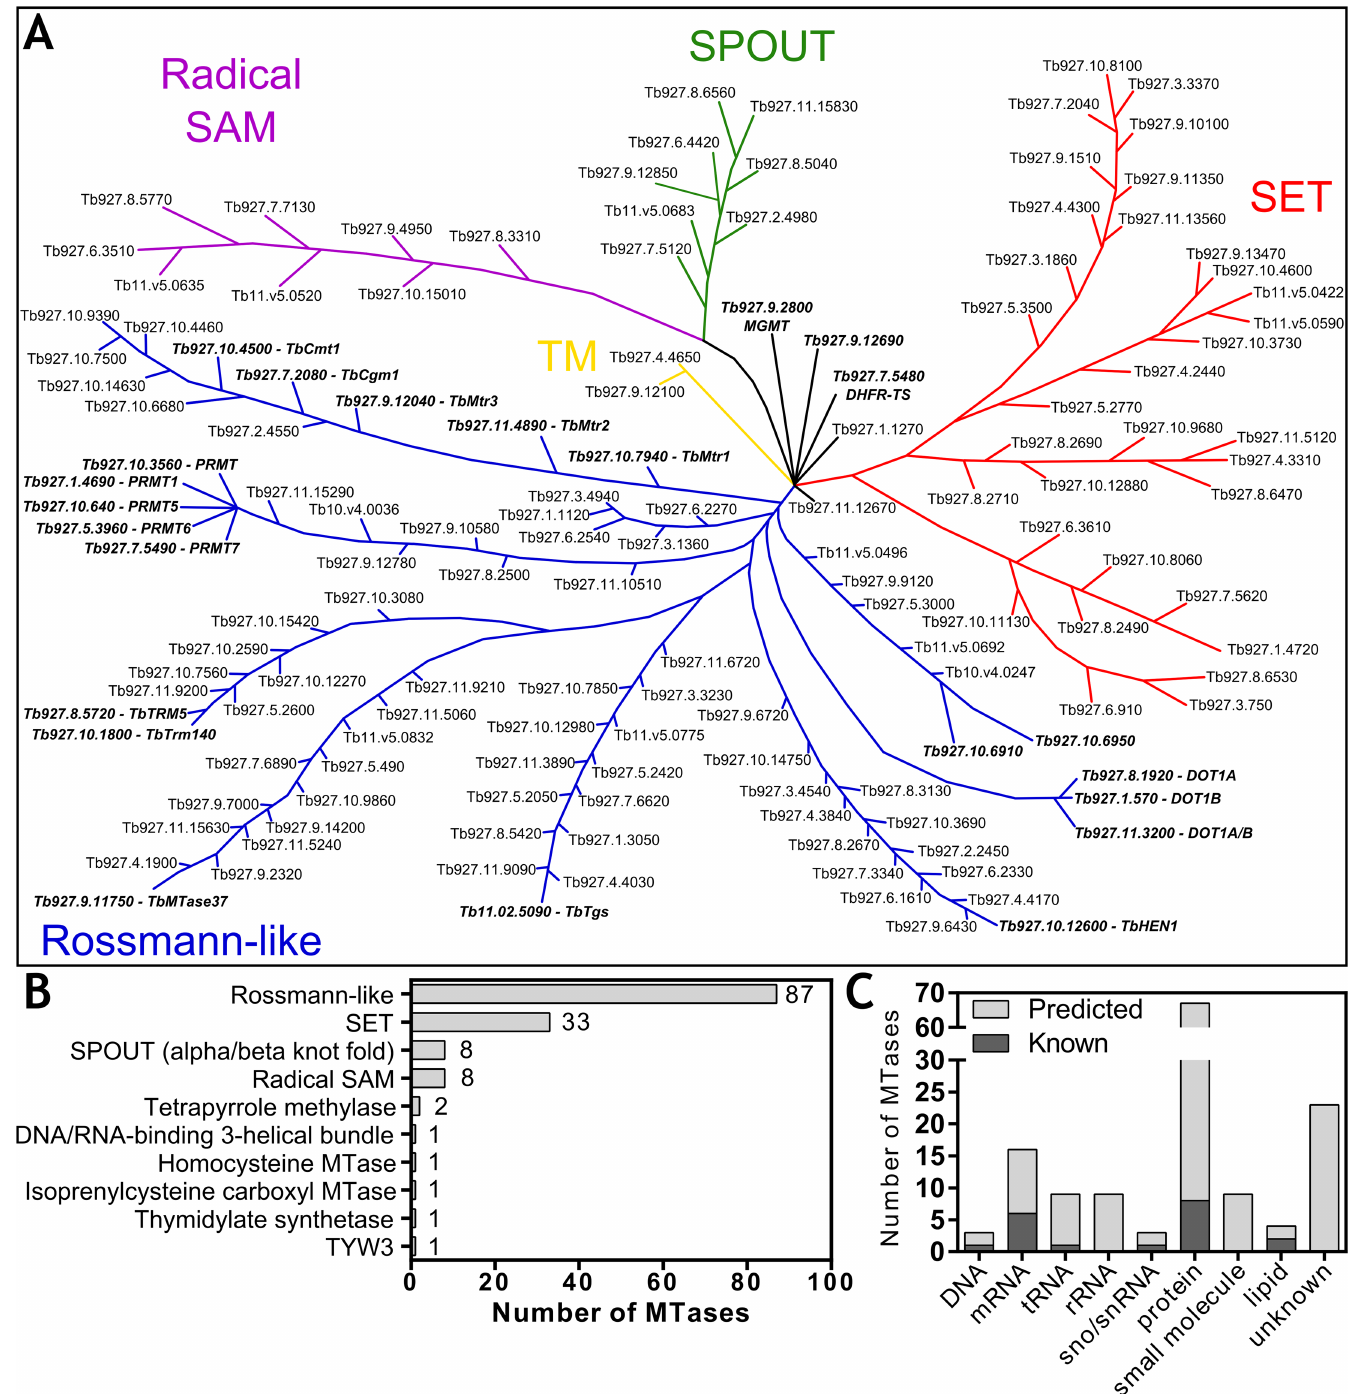
Fig 7. The T . brucei “methyltransferome”. A) A stylised tree depicting the entire methyltransferase complement of T . brucei , clustered based on domain class as designated by Schubert and colleagues [52]. The arrangements of genes and branch lengths carry no significance as methyltransferases are highly diverse, making generation of a phylogenetic tree challenging. Gene IDs in bold italics have been previously characterised. Abbreviations: TM: Tetrapyrrole methylase. B) Number of members in each class of methyltransferase. Enzymes containing Rossmann-like folds and SET domains are numerous compared to the remaining classes. C) Methyltransferases grouped by the substrate they methylate. The majority of MTases studied include spliced leader RNA MTases and protein arginine MTases. SET domain-containing proteins are likely lysine